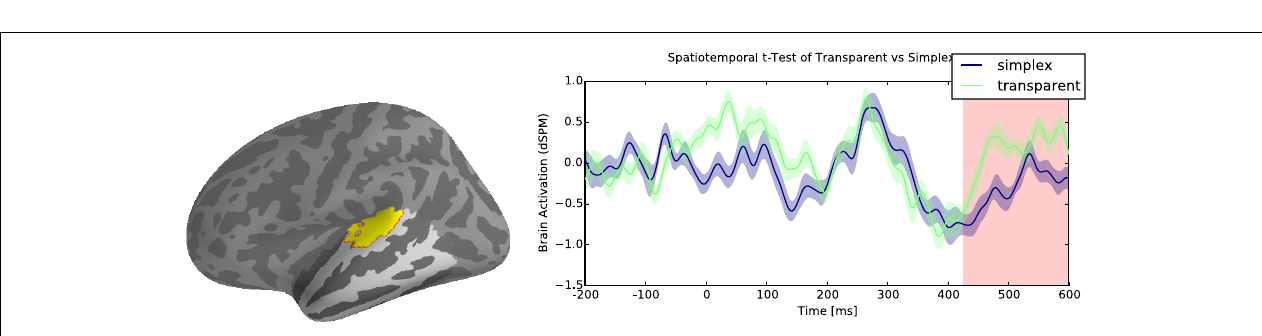
Frontiers in Human Neuroscience |